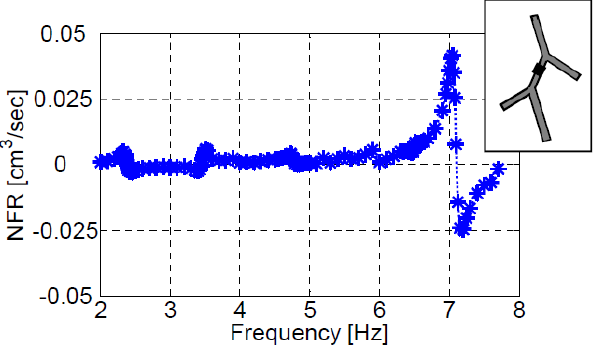
Figure 10. The dependence of NFR on the actuation frequency for an actuator positioned on the first vessel of configuration V, at X C / L = 0.4.